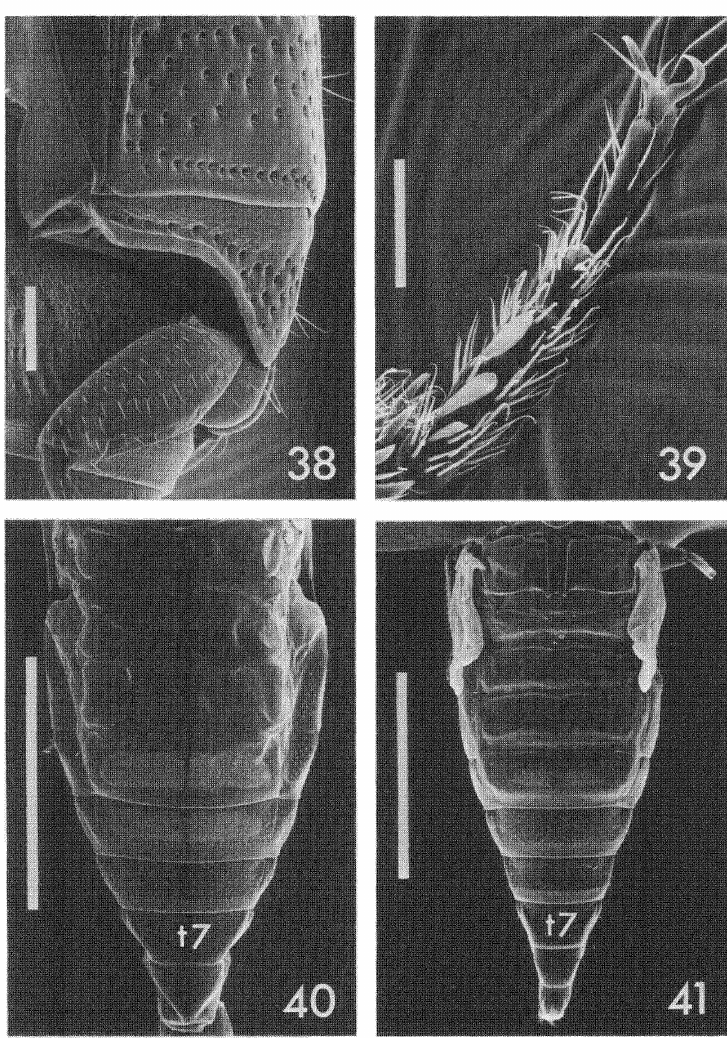
Figs. 38-41. Glypholoma spp. 38-40. G. pustuliferum; 38, metasternum and right metacoxa, lateral view; 39, male left mesotarsus, ventral view; 40, abdomen, dorsal view. 41. G. rotundulum, pterothorax and abdomen, dorsal view. t7 tergite 7. Scale lines: figs. 38, 39 0.1 mm; figs. 40, 41 1.0